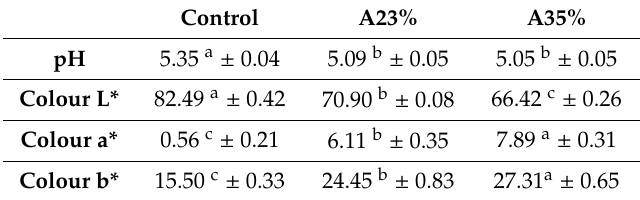
Table 2. Colour parameters and pH of GF doughs (control, A23% and